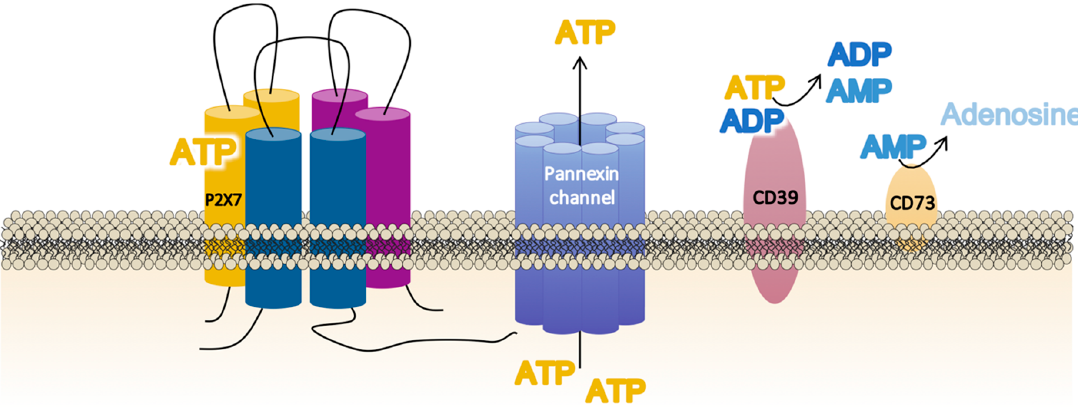
Figure 2. Schematic illustration of the main membrane proteins involved in the regulation of the extracellular adenosine triphosphate (ATP) levels required for P2X7 receptor (P2X7R) function. The P2X7R activation requires large ATP release through nearby membrane structures such as the pannexin channel, but the precise balance of the extracellular ATP concentrations is also dependent on the activity and membrane localization of the enzymes CD39 (NTPDase-1), which dephosphorylates ATP to adenosine diphosphate (ADP) and adenosine monophosphate (AMP), and CD73 (ecto-5 ′ ecto nucleotidase), which turns AMP into adenosine. 4. Cell Localization of the P2X7 Receptor is Crucial for the Nearby Interactions P2X7R has been described mainly as a cell surface receptor. Uniform endogenous P2X7R